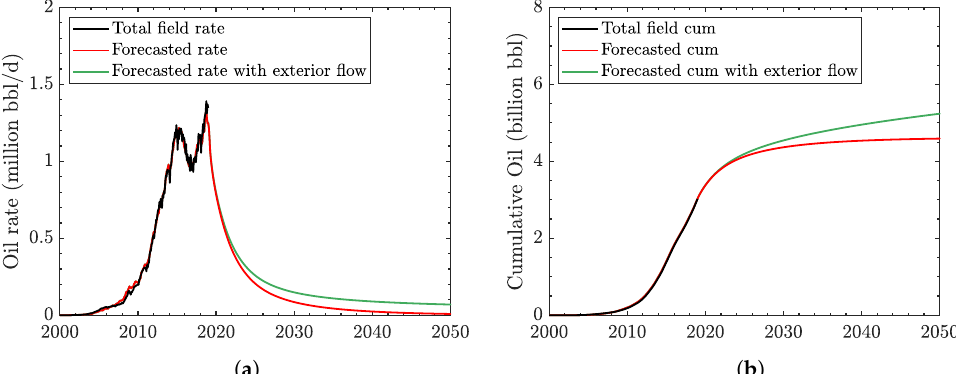
Figure 7. The actual and forecasted total field rate ( a ) and cumulative oil ( b ) in the Bakken shale. Total field cumulative production curves were obtained by stacking calendar-shifted average wells. Total production rates were obtained by differencing cumulative production. The red and green curves are the physical scaling forecasts with and without exterior flow, while the black line shows the historical production from the existing 14,678 wells. The red physical scaling gives the lower bound of EUR estimate with about 4.5 billion bbl by 2050. Assuming reasonable exterior flow, EUR prediction becomes slightly more than 5 billion